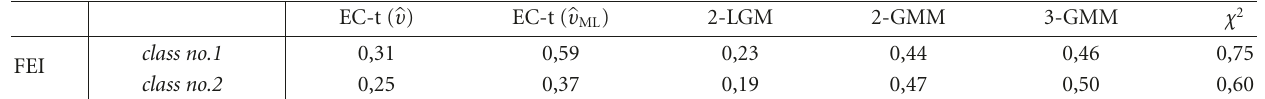
Table 4: Fitting error index ( FEI) values.